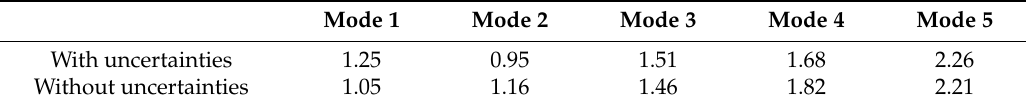
Table 2. The detection times of SOSMO scheme in scenarios with uncertainties